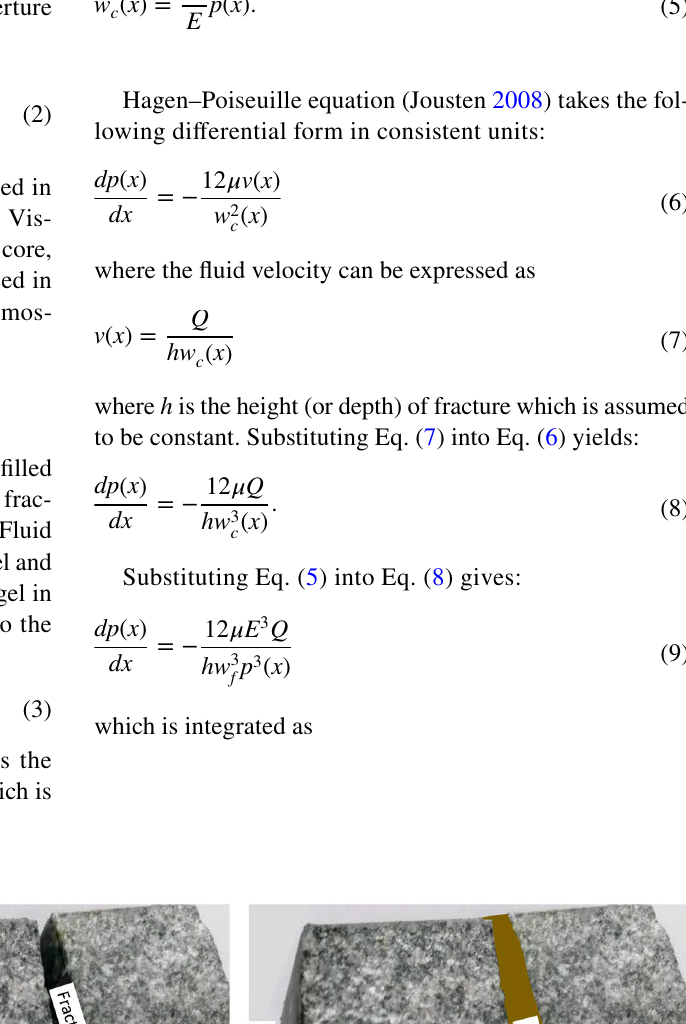
Fig. 4 Fluid-channeling in a gel-filled fracture. a Fracture before gel placement, b fracture filled with gel, c fluid squeezed into gel-sealed fracture, d pressure-induced stress in